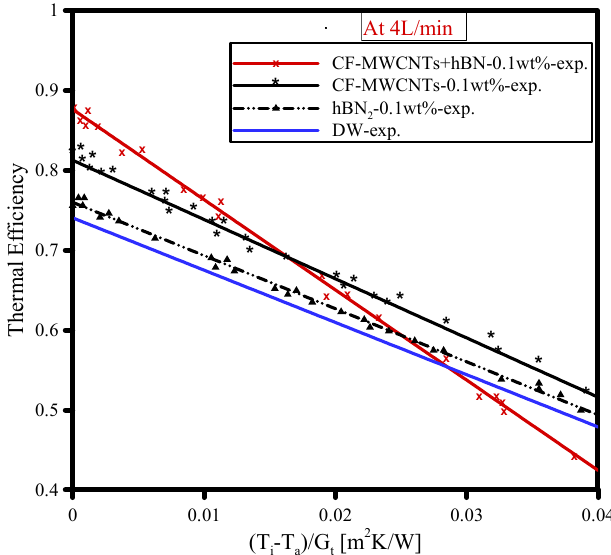
Figure 13. Thermal efficiency versus reduced temperature parameter at 860 W/m 2 and 30 °C at 0.1 wt.% for hBN, CF-CNTs, and hBN/CF-CNTs water-based nanofluids.